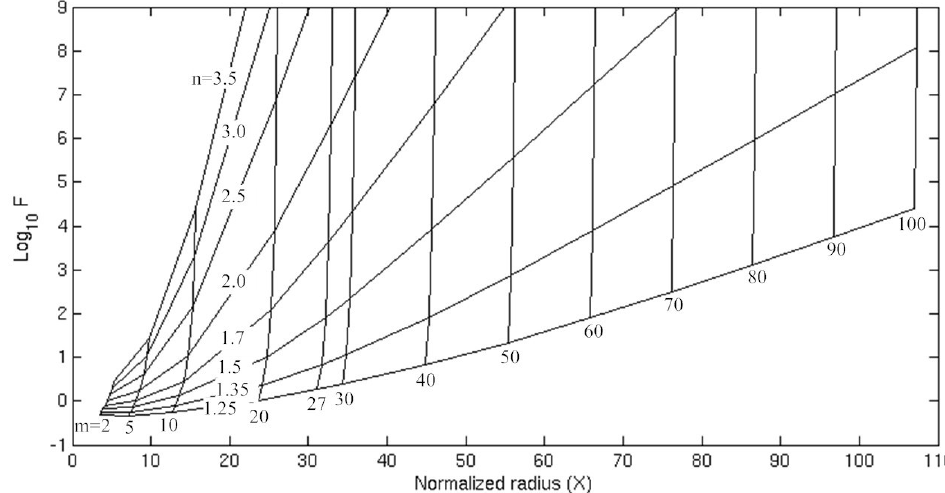
Figure 2. Radiation-loss-limited fi nesse (F) of the lowest order radial WGMs of a hollow cylindrical dielectric waveguide of index n against normalized radius